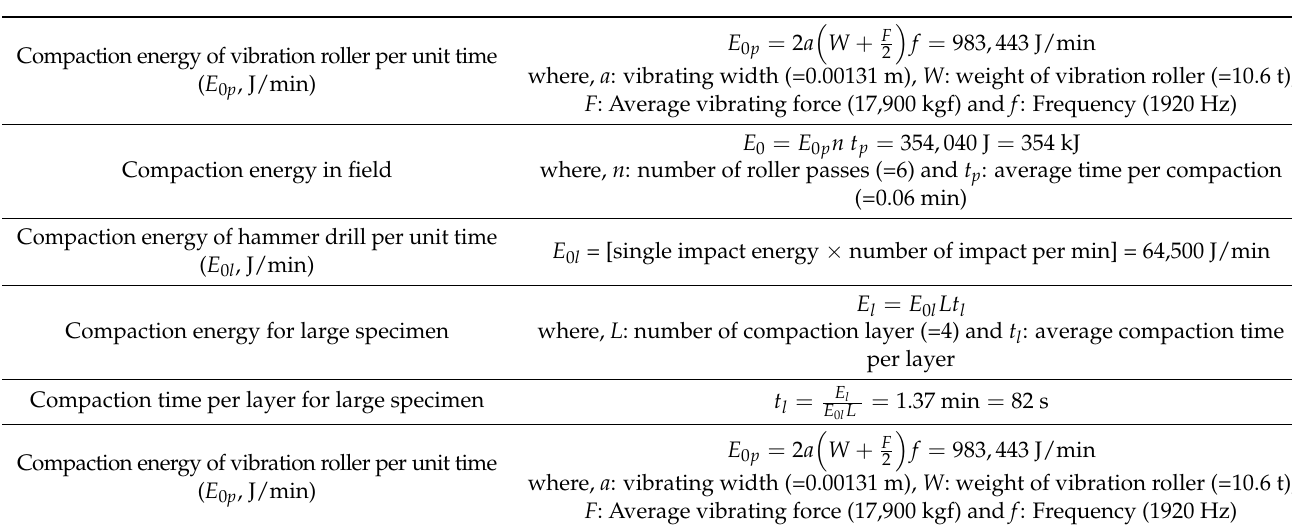
Table 3. Estimation of compaction energy for large